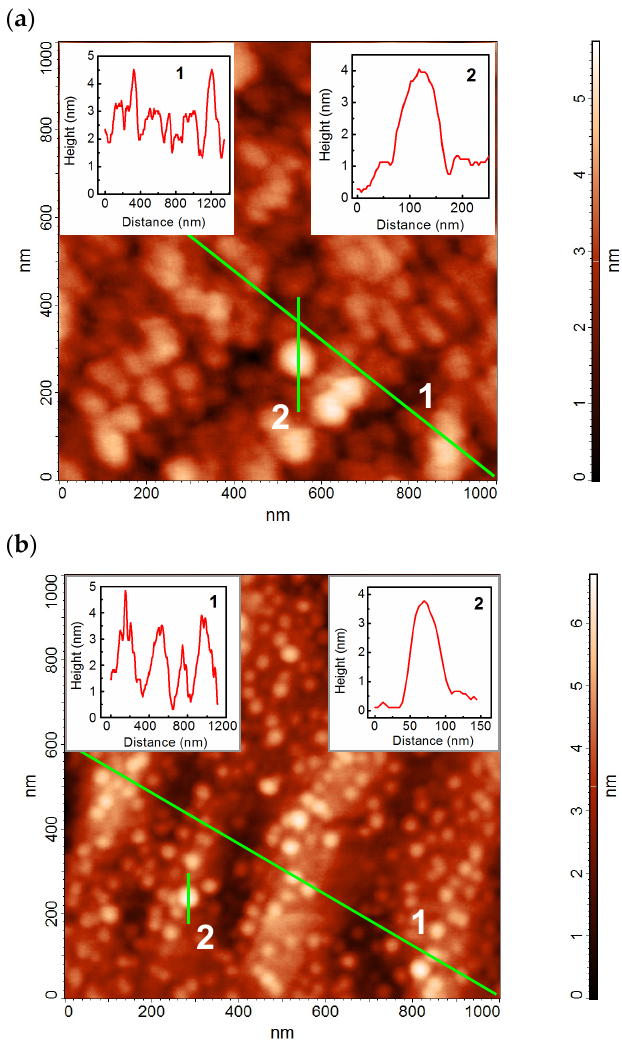
Figure 4. AFM images of the surface of HSs ( a ) B and ( b ) D . The surface height profiles along different sections are shown in the insets. Table 1. Parameters of the QD array formed in HSs B and D , as well as the AlP surface relief parameters in these